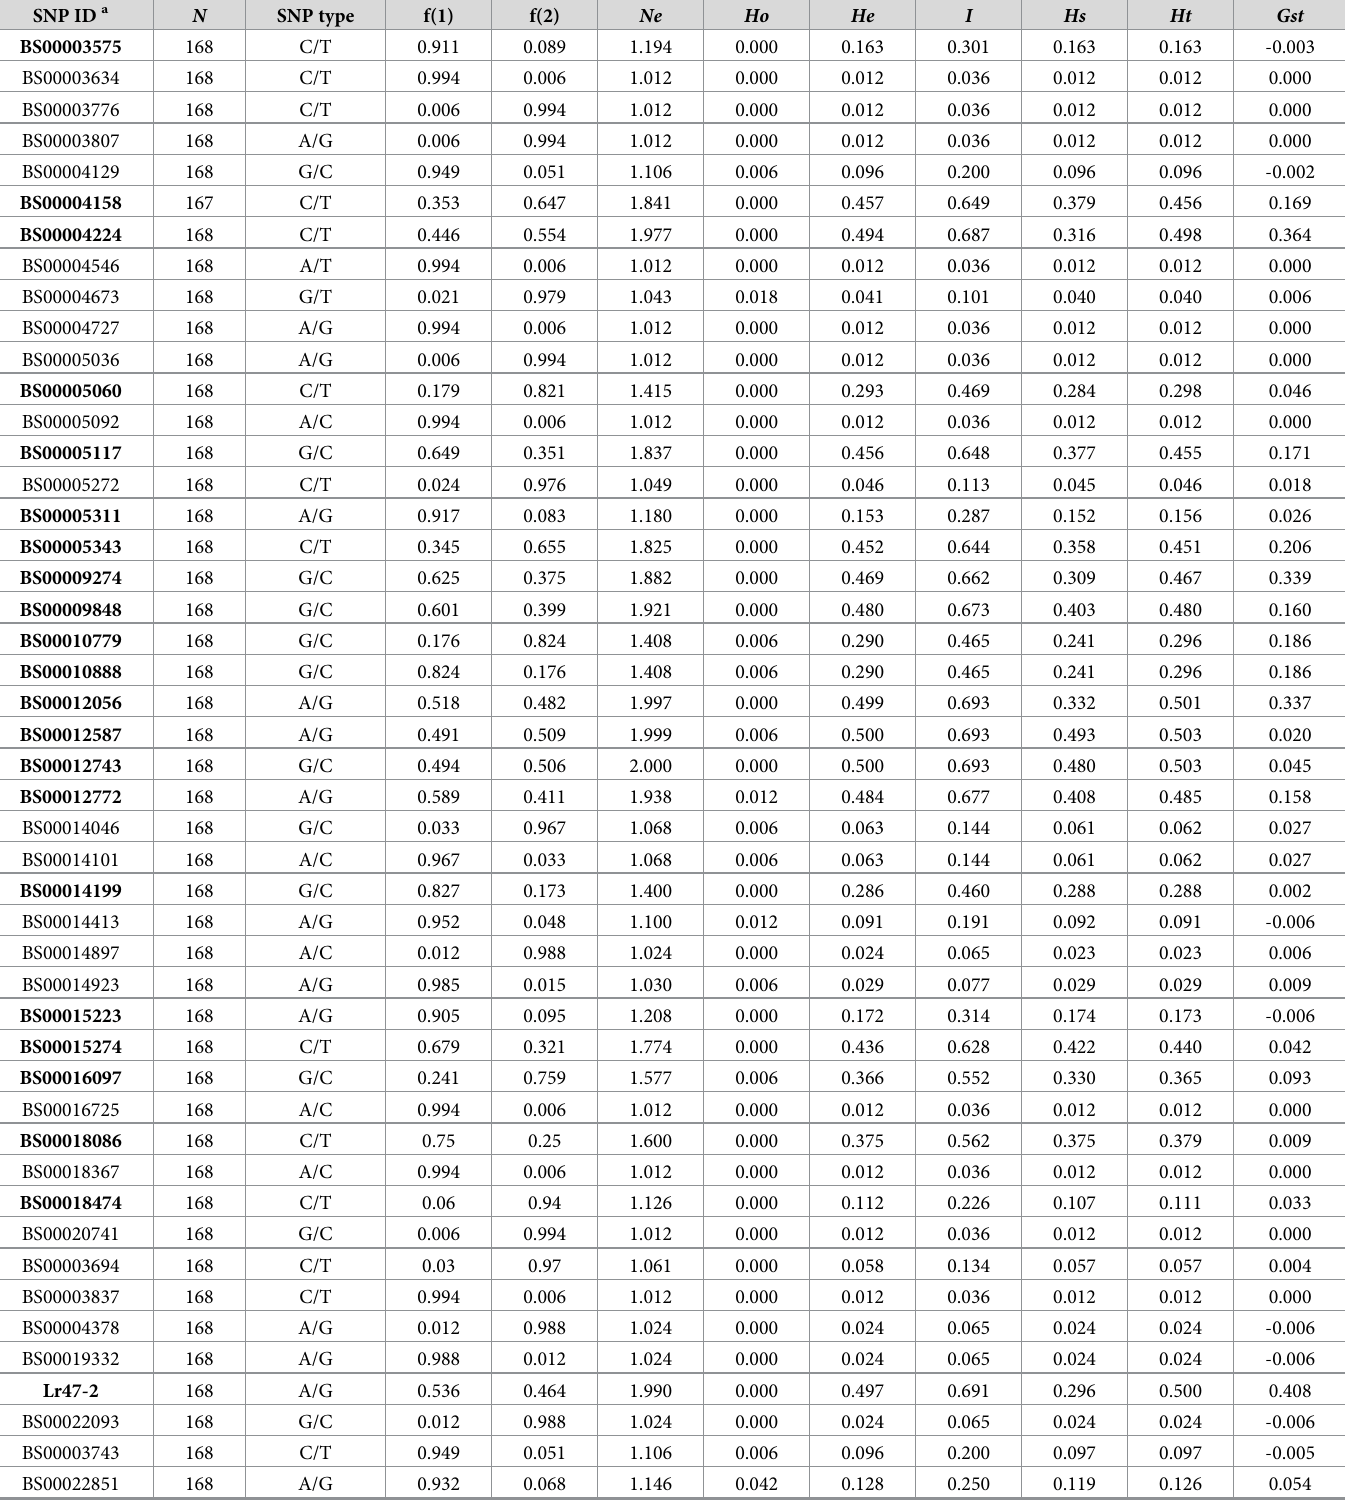
Table 6. Allele frequencies and genetic diversity indices estimated per locus using 56 SNP markers in a durum wheat collection of 168